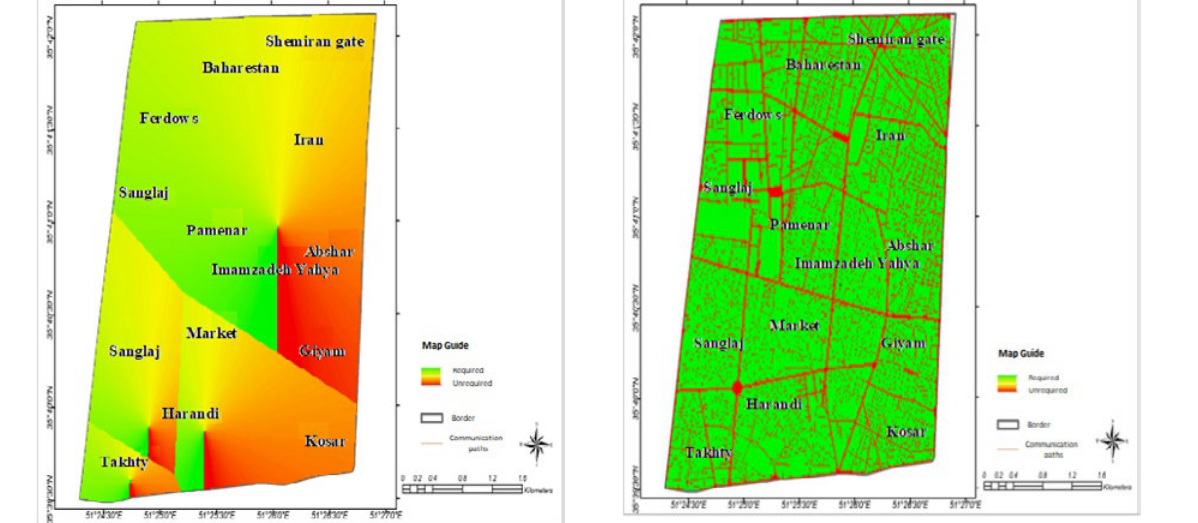
Fig. 4: Distance map of the populated centers and population den- sity of the District Fig. 4: ‐ Distance map of the populated centers and population density of the District 12